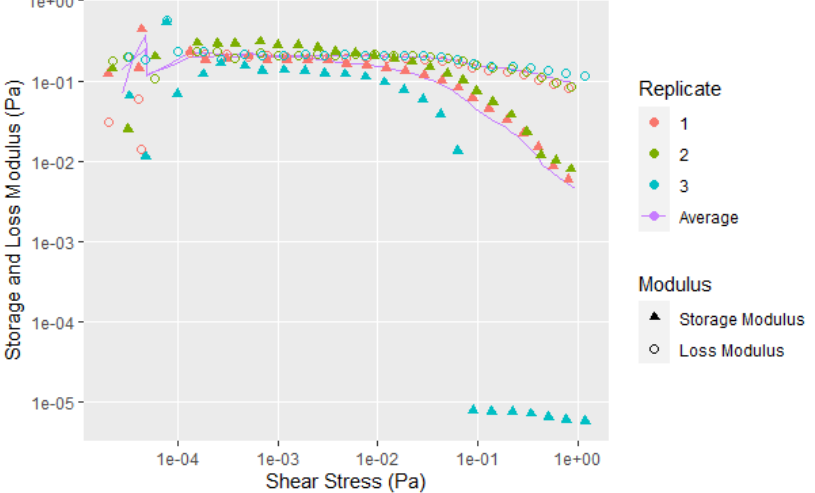
Figure A1. Individual amplitude sweep data for mixtures of 90 PDI flour with 1 h mixing time and 10% solid content.